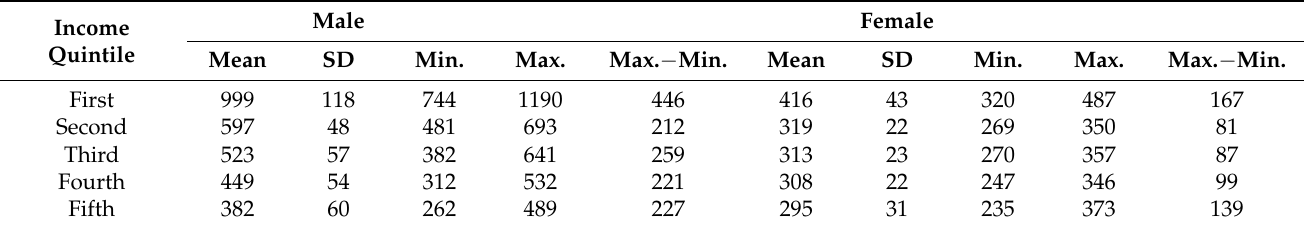
Table 2. Distribution of age-adjusted mortality rate per 10,000 persons across 25 districts in Seoul for the period of 2014 to 2018 for men and women aged